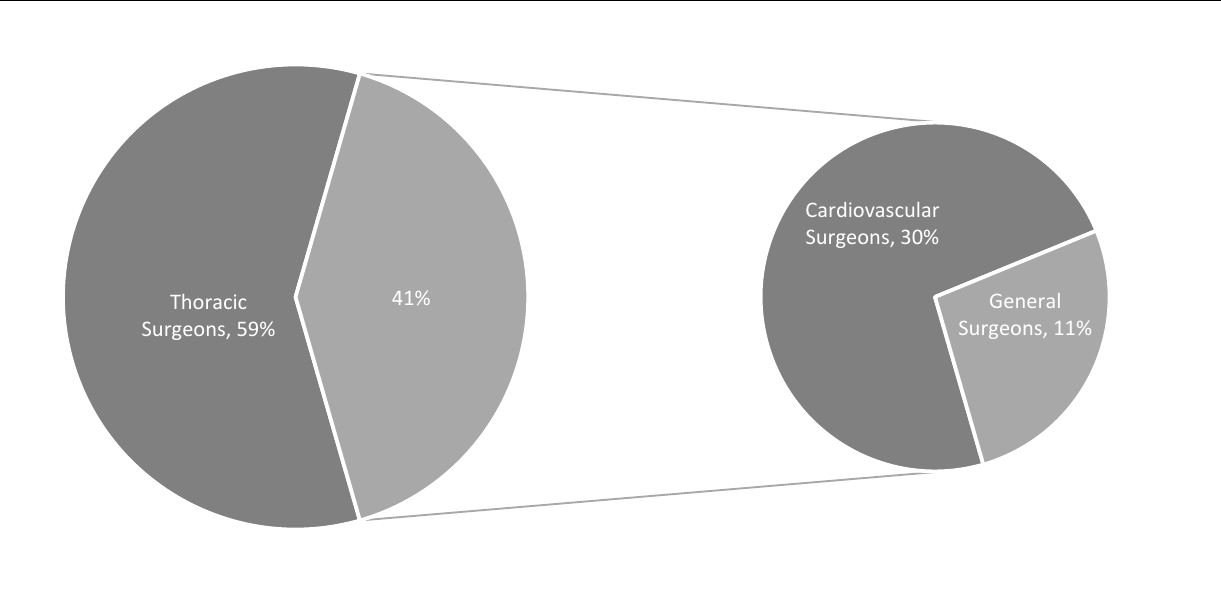
Figure 2. Distribution of lung lobectomies performed by each provider type in the Premier Healthcare Database from 2009 to 2019. Unadjusted analysis revealed several differences between the two groups (Table 1). Patients receiving lobectomy from a thoracic surgeon were more likely to have private insurance (24% vs. 21%, p < 0.001), be treated at a hospital with >500 beds (62% vs. 38%, p < 0.001), be in an urban setting (61% vs. 40%, p < 0.001), and be treated at a teaching hos ‐ pital (58% vs. 42%, p < 0.001).